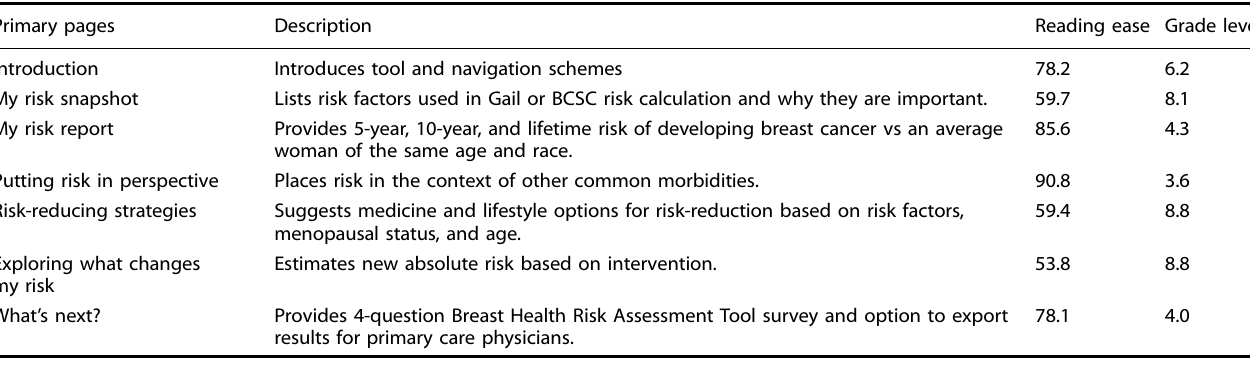
Table 1. Page description and calculated readability.